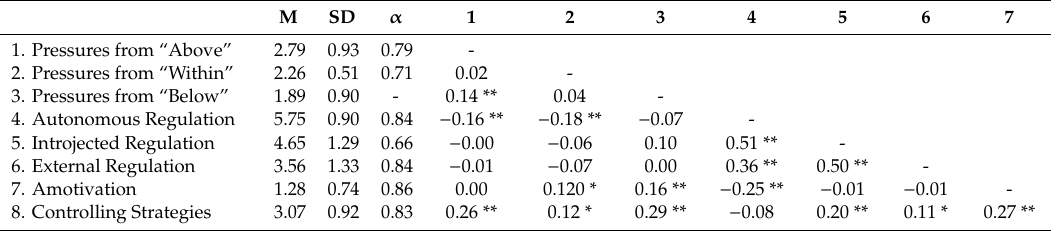
Table 1. Descriptive and correlational analysis among the study